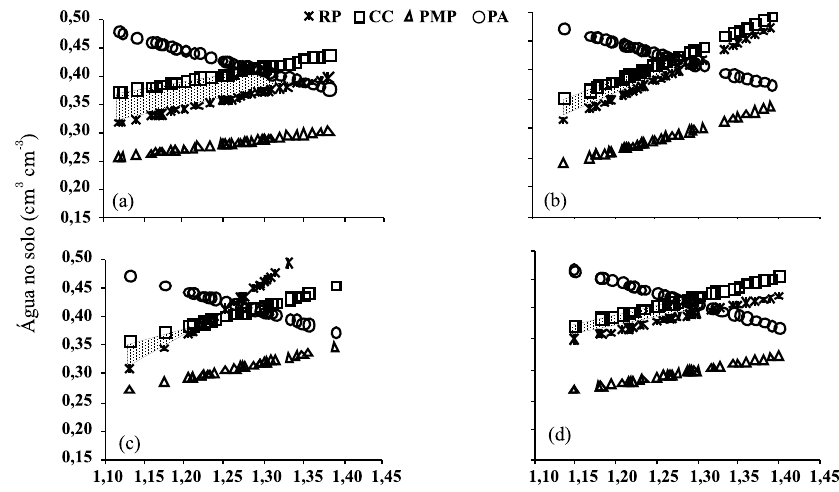
Figura 1. Variação do conteúdo de água no solo, em função da densidade aparente, para atender aos níveis críticos de capacidade de campo (CC = -0,01 MPa), ponto de murcha permanente (PMP = -1,5 MPa), porosidade de aeração (PA = 10 %) e resistência à penetração (RP = 2 MPa). A área hachurada representa o IHO para os tratamentos milho solteiro (a, c) e milho consorciado com braquiária na linha de semeadura (b, d), nas camadas de 0 a 20 cm (a, b) e 20 a 40 cm (c,